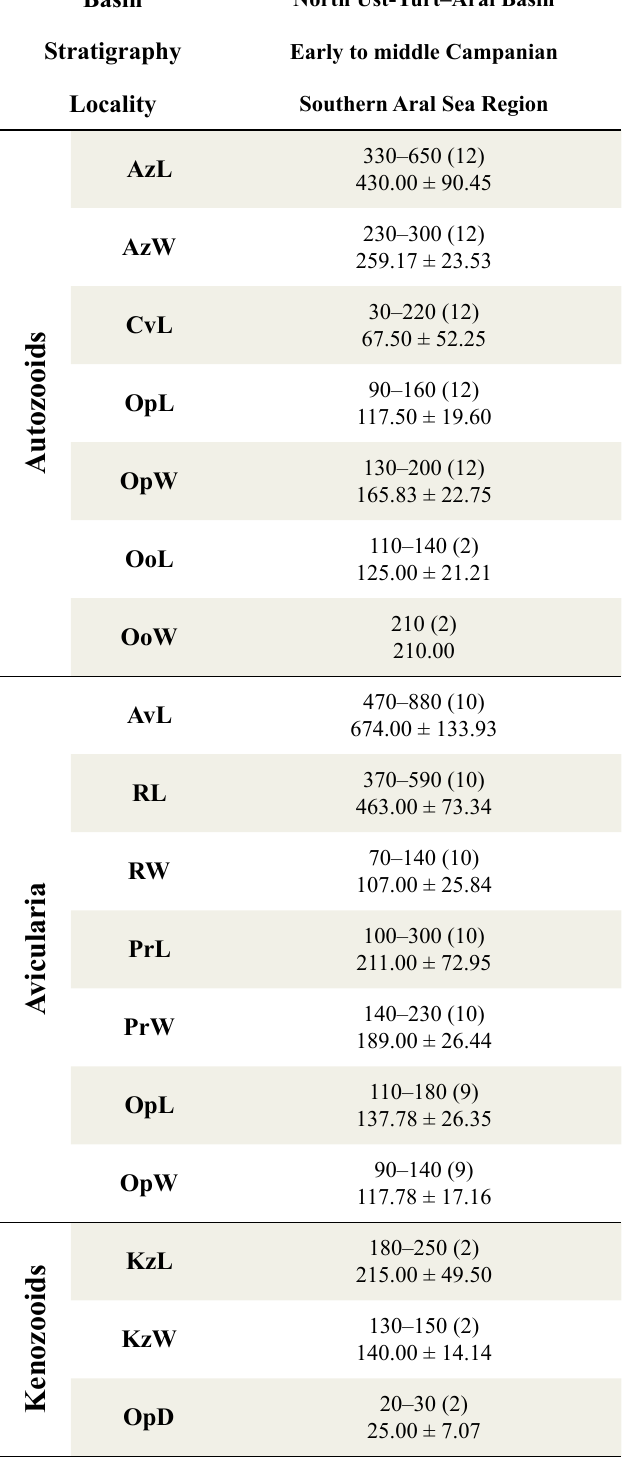
Table 5. Summary of measurements of Rhagasostoma aralense sp. nov. For each parameter the range is given with the number of measurements in brackets. The arithmetic mean is given ± standard deviation. All measurements in